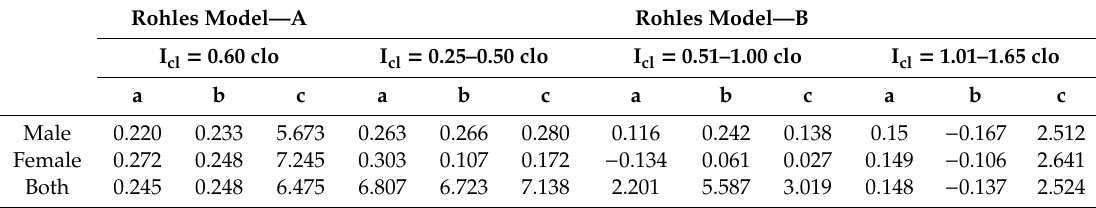
Table 1. Coe ffi cients a, b, and c for the application of the Rohles models for di ff erent range value of I cl [14,15]. Rohles Model—A Rohles